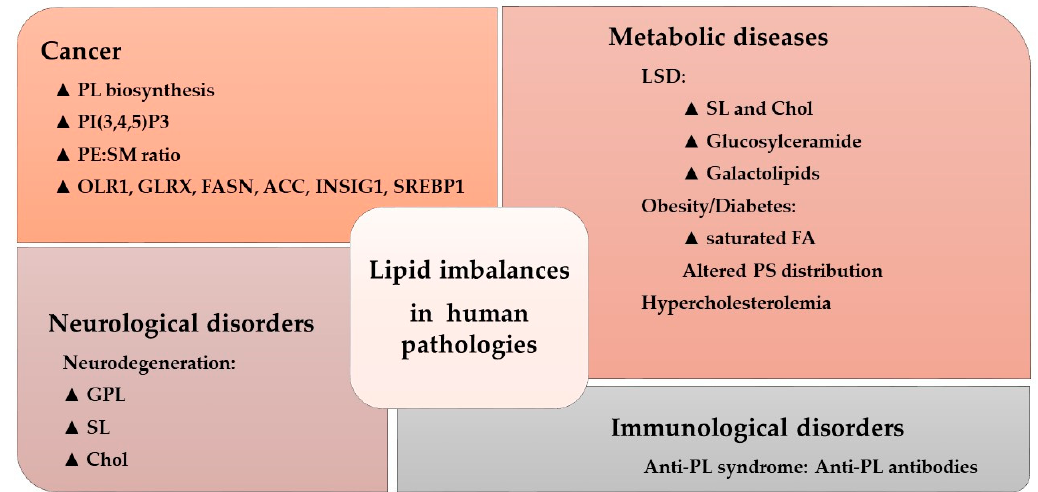
Figure4. Lipidimbalancesandhumanpathologies. Alterationstothelipidomeinavarietyofconditions. The triangle indicates increased levels or pathway activity: PL, phospholipid; PtdIns(3,4,5)P3, phosphatidylinositol 3,4,5-trisphosphate; PE, phosphatidylethanolamine; SM, sphingomyelin; OLR1, oxidized low-density lipoprotein receptor 1; GLRX, glutaredoxin; FASN, FA synthase; ACC, acetyl-CoA carboxylase; INSIG1 , insulin induced gene 1; SREBP1, sterol regulatory element-binding protein 1; LSD, lysosomal disorder; SL, sphingolipid; Chol, cholesterol; FA, fatty acid; PS, phosphatidylserine (Adapted from